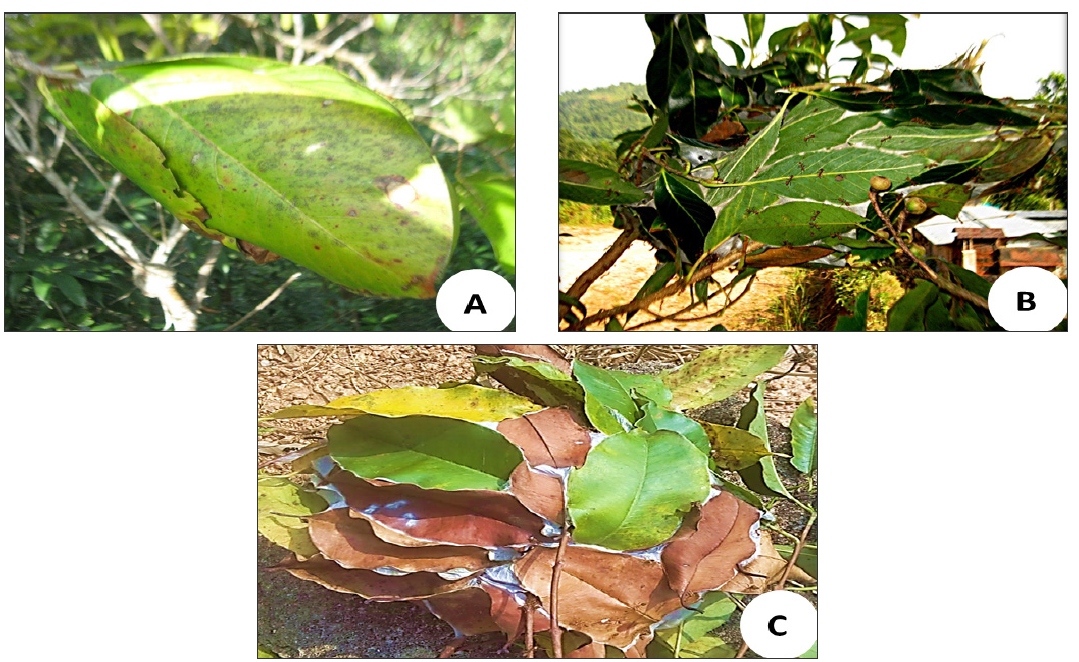
Fig 6 . Representative photographs of an irregular oval-ellipse-shaped nests of O. smaragdina on needlewood tree ( Schima wallichi ). Smallest nest (A), large nest (B), and a nest containing pale yellow to brown leaves (C).